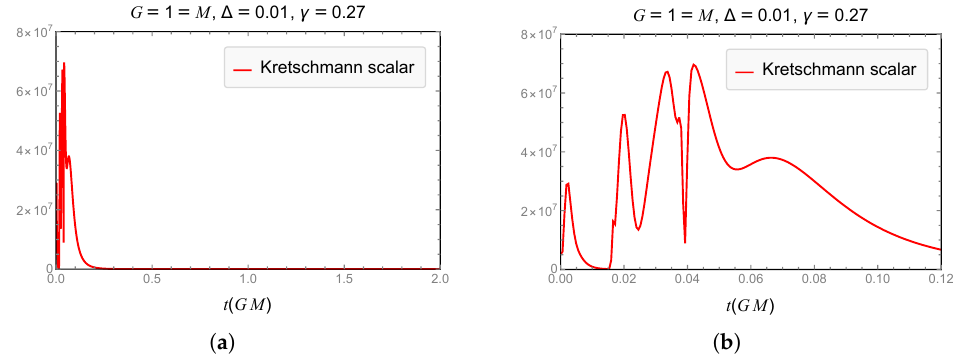
Figure 14. K in the ¯ µ (cid:48) case. ( a ) The Kretschmann scalar K for the ¯ µ (cid:48) case as a function of the Schwarzschild time t . ( b ) Close up of K close to t = 0. It is seen that K remains finite everywhere in the interior and vanishes for t =